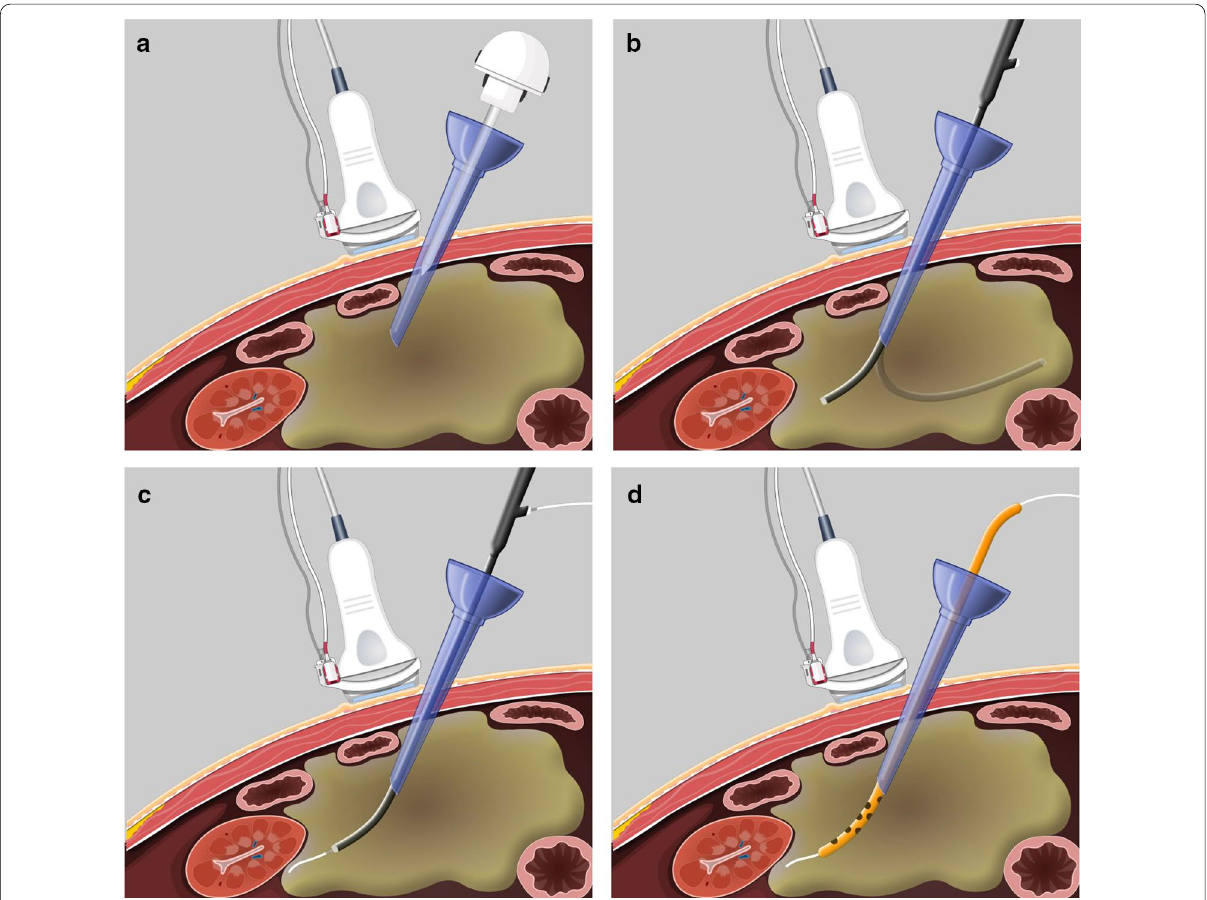
Fig. 1 Schematic of the modified percutaneous catheter drainage procedure under the triple guidance of choledochoscopy, ultrasonography (US), and computed tomography (CT). a A laparoscopic trocar is inserted into the necrotic cavity under the guidance of an US/CT imaging system. b After the withdrawal of the core, a choledochoscope is inserted through the trocar to detect the necrotic cavity and to debride the necrosis if needed. c Under the triple‑guidance system, the guidewire is placed at the sloping position of the walled‑off necrosis (WON), penetrating the necrotic cavity. d A multi‑side‑hole catheter is then inserted along the guidewire to drain the